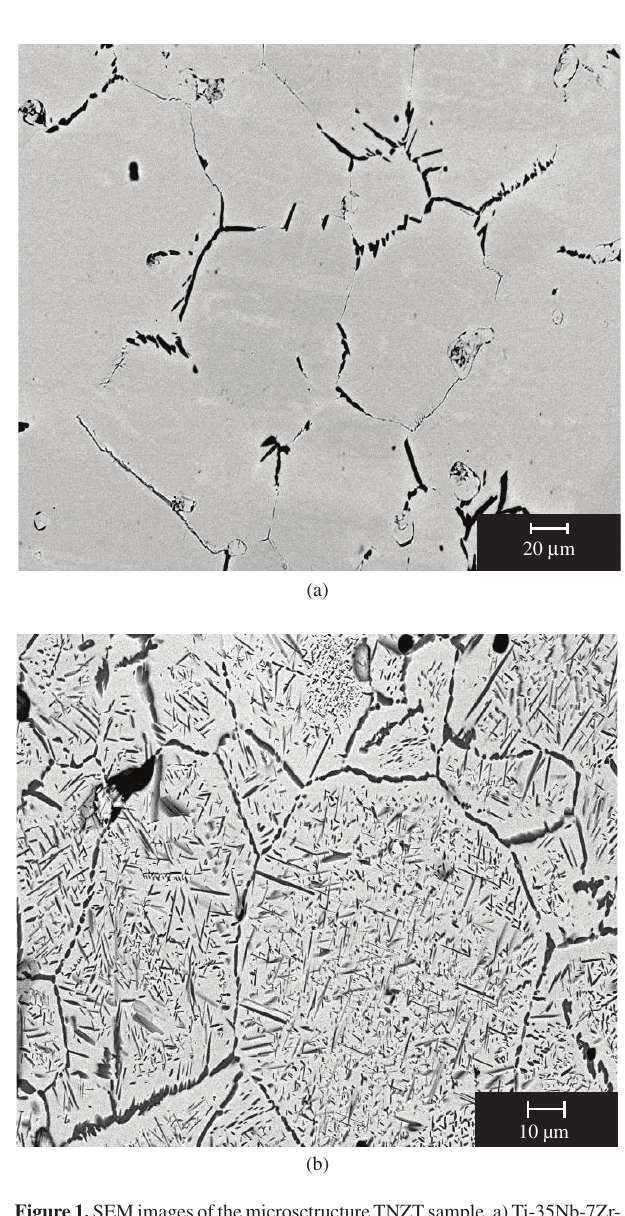
Figure 1. SEM images of the microsctructure TNZT sample. a) Ti-35Nb-7Zr- 5Ta sintered at 1500 °C; and b) Homogenized TNZT